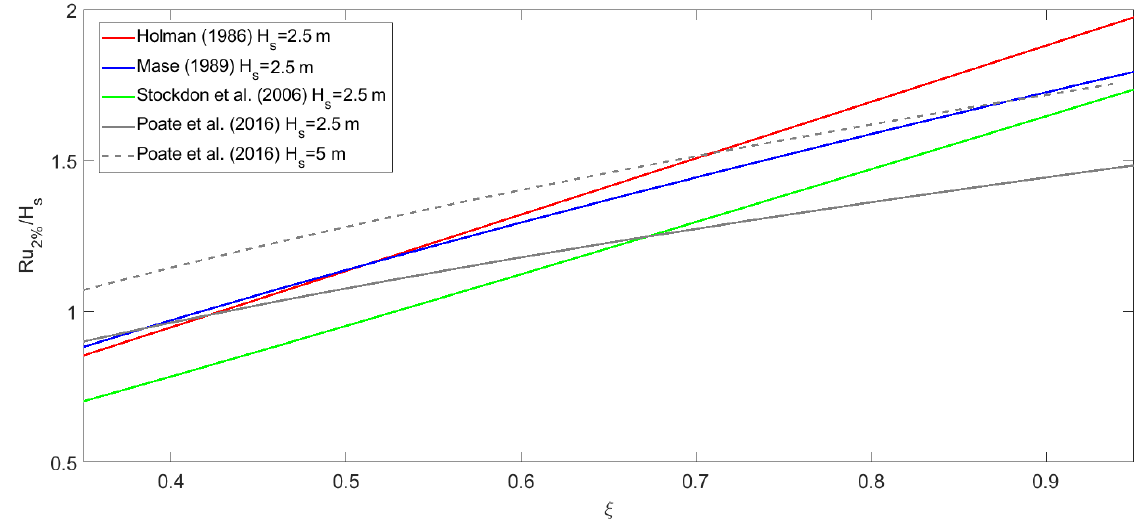
Figure 9. Ru 2% /H s as a function of the Iribarren number ξ for the different equations with reference to the wave conditions of the Febru- ary 2016 storm ( H s = 2 . 5m) and, only for Poate et al. (2016), the same values calculated in more energetic conditions ( H s = 5 . 0m, dotted